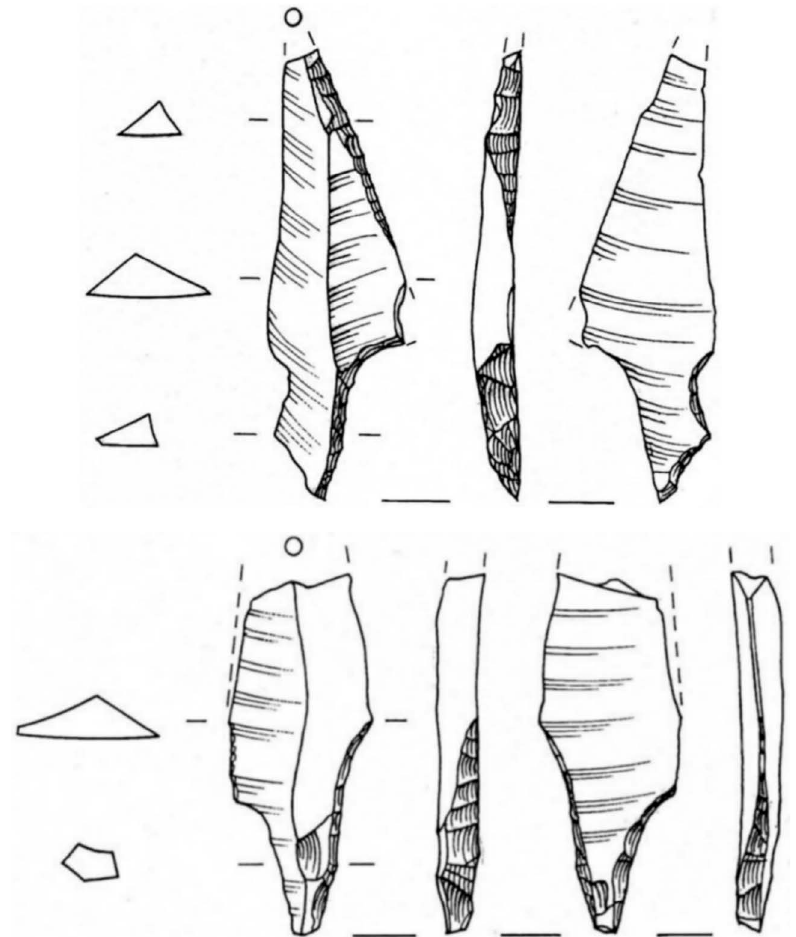
Figure 5. Two tanged points from Howburn (top: CAT 4041: length 42mm; bottom: CAT 1734: length 32 mm). Both points were recovered in connection with the second excavation on the site in 2009, and they will be discussed in Ballin et al. in press .